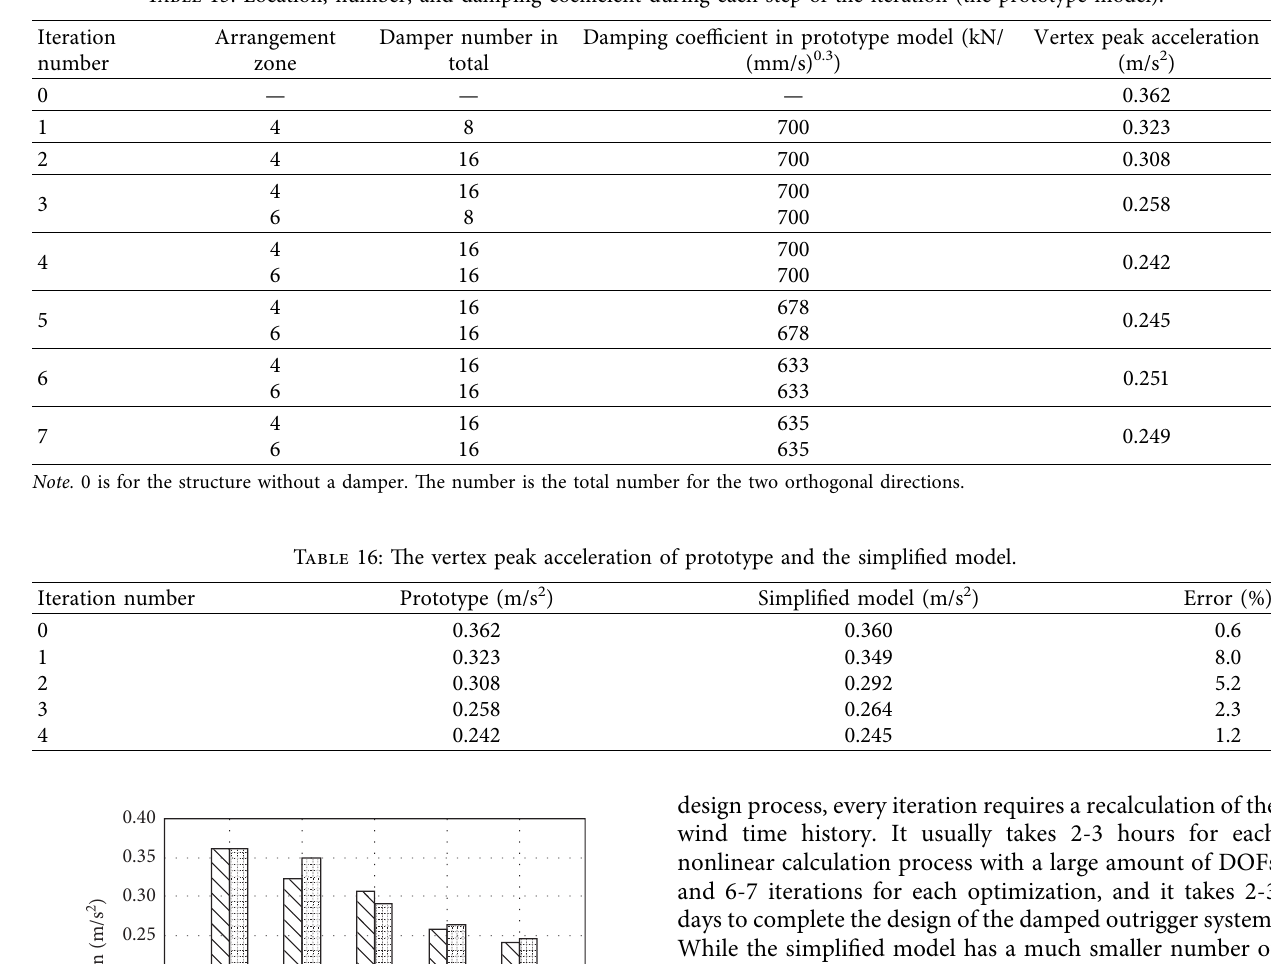
Table 15: Location, number, and damping coefficient during each step of the iteration (the prototype model).